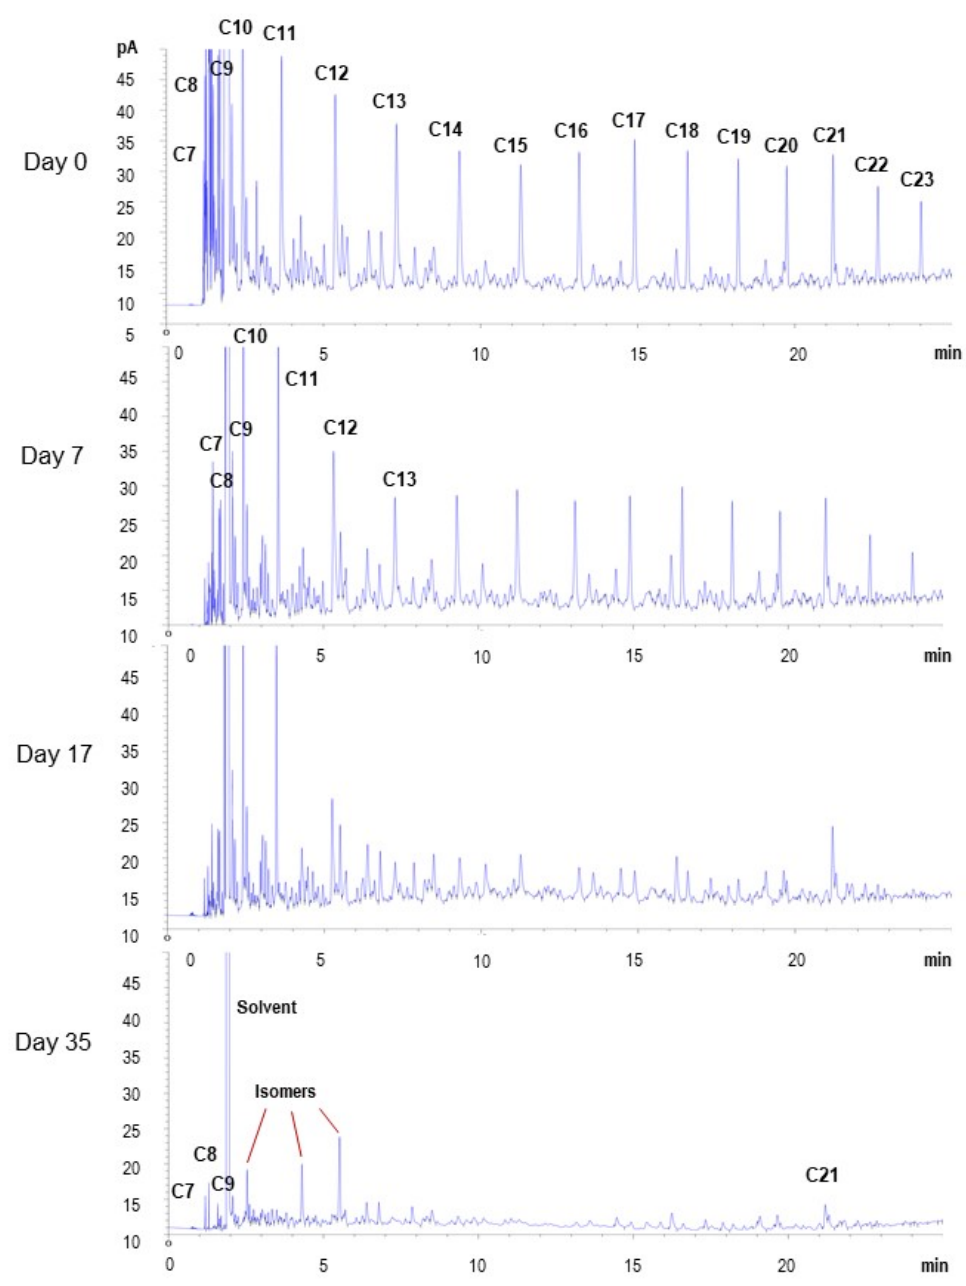
Figure 6. GC-FID chromatograms of Arab Light degradation by Pseudomonas putida . Degradation of C7–C12 aliphatic alkanes is lower during the first days of incubation compared to B. licheniformis . Residual peaks in the last chromatogram (day 35) are not significant in area value (<10 pA*s).